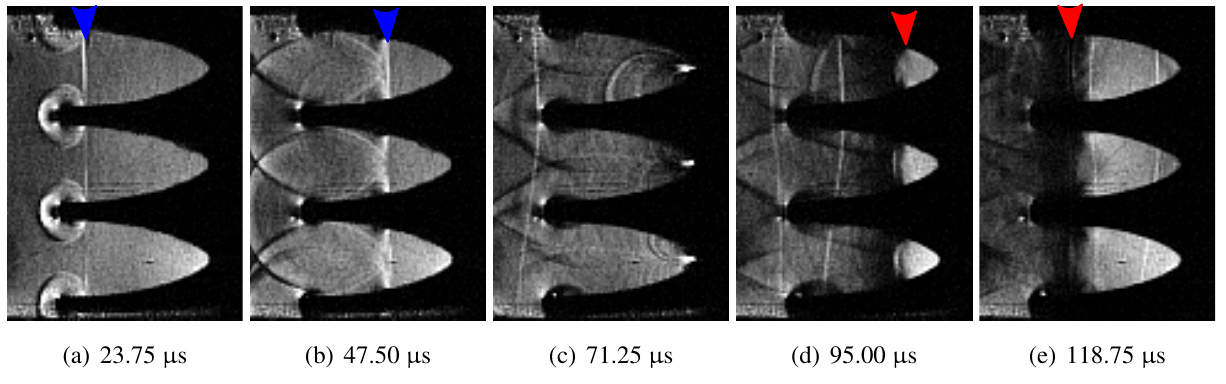
Figure A4. Closed cell foam, Case 3C.